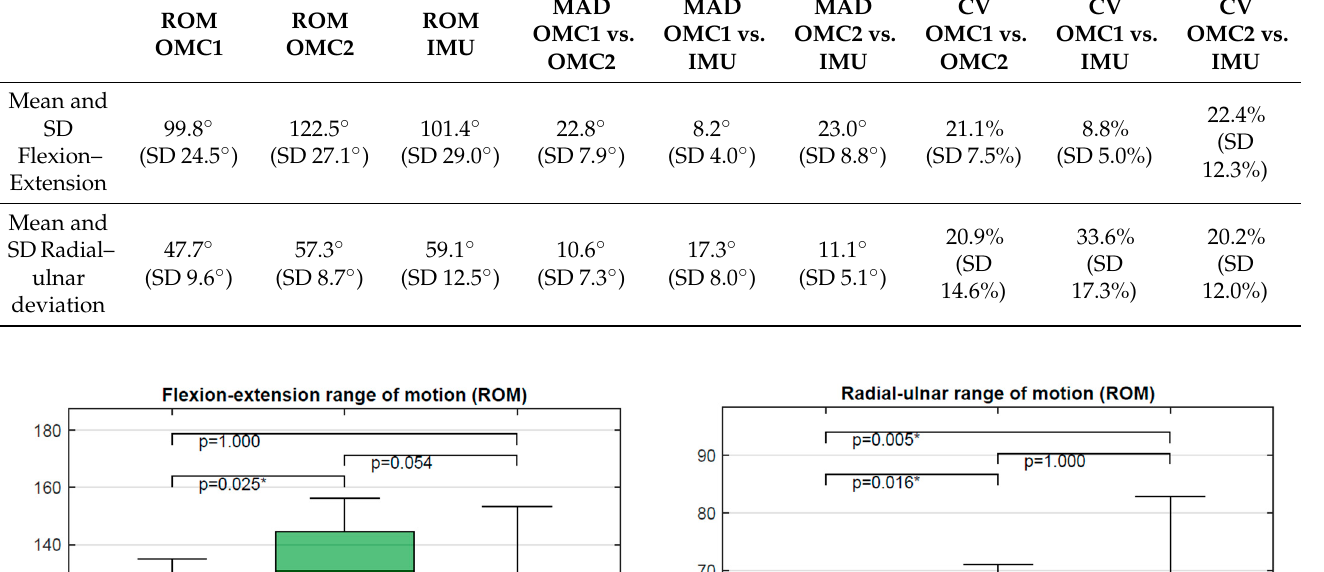
Figure 7. ( a ) RMSE of flexion–extension (filtered) derivative between OMC1, OMC2, and IMU acquisition systems and ( b ) RMSE of radial–ulnar deviation (filtered) derivative between OMC1, OMC2, and IMU acquisition systems. For Values marked as *, the difference is statistically significant. Table 1. Summary of the mean (±SD) ROM DTM in both the flexion–extension and radial–ulnar deviation planes for each system, as well as the mean absolute difference (MAD) and the coefficient of variation (CV) between the different systems.